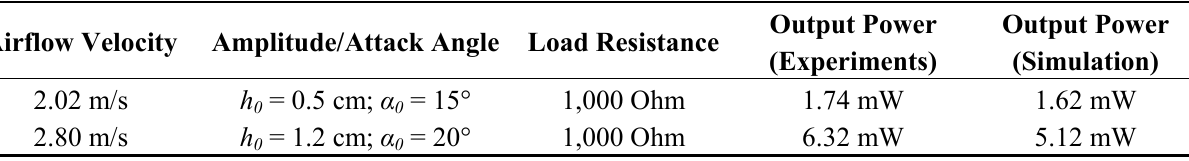
Table 3. Comparison of experimental results and simulated